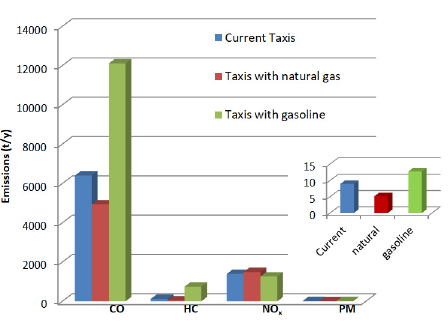
Figure 1. Total regulated emissions from taxis with different